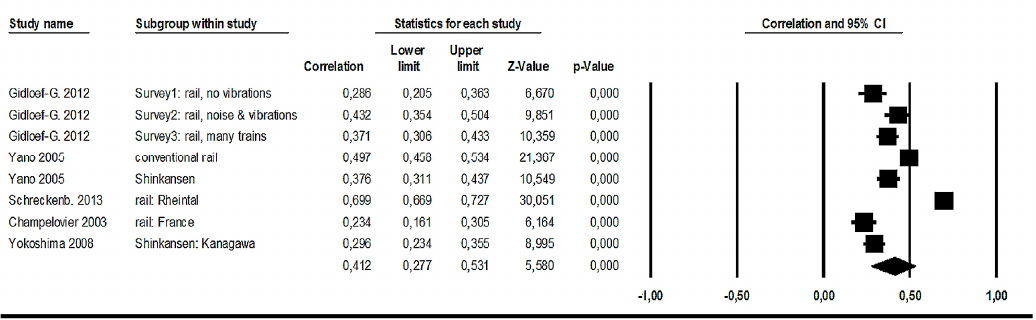
Table 6. Railway traffic noise—HA rates and the number of respondents in two classes of exposure ( L Aeq,24h ).